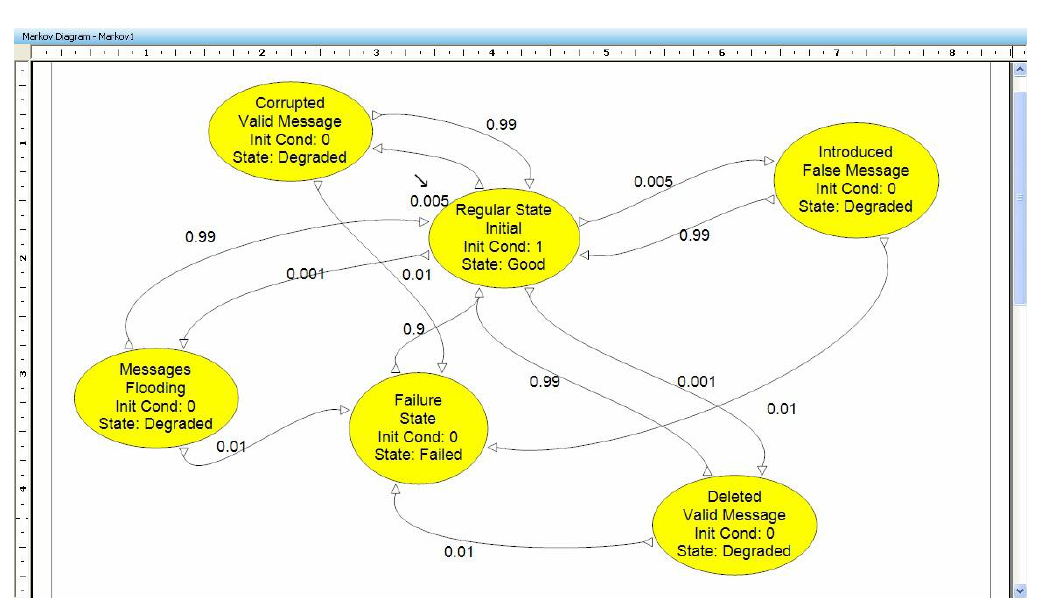
Table 2. Simulation results.